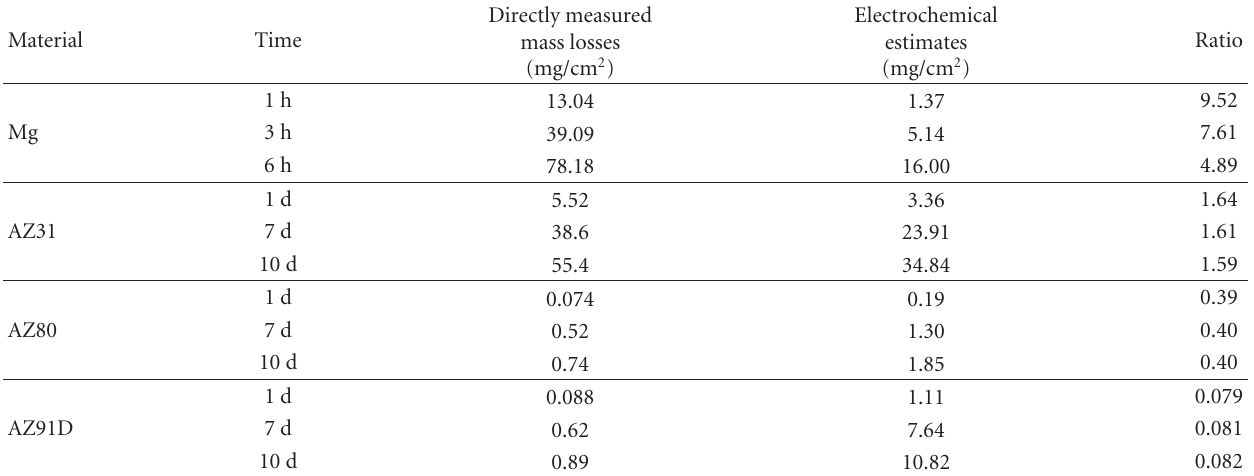
Table 2: Comparison between direct mass losses and the corresponding electrochemical estimates.